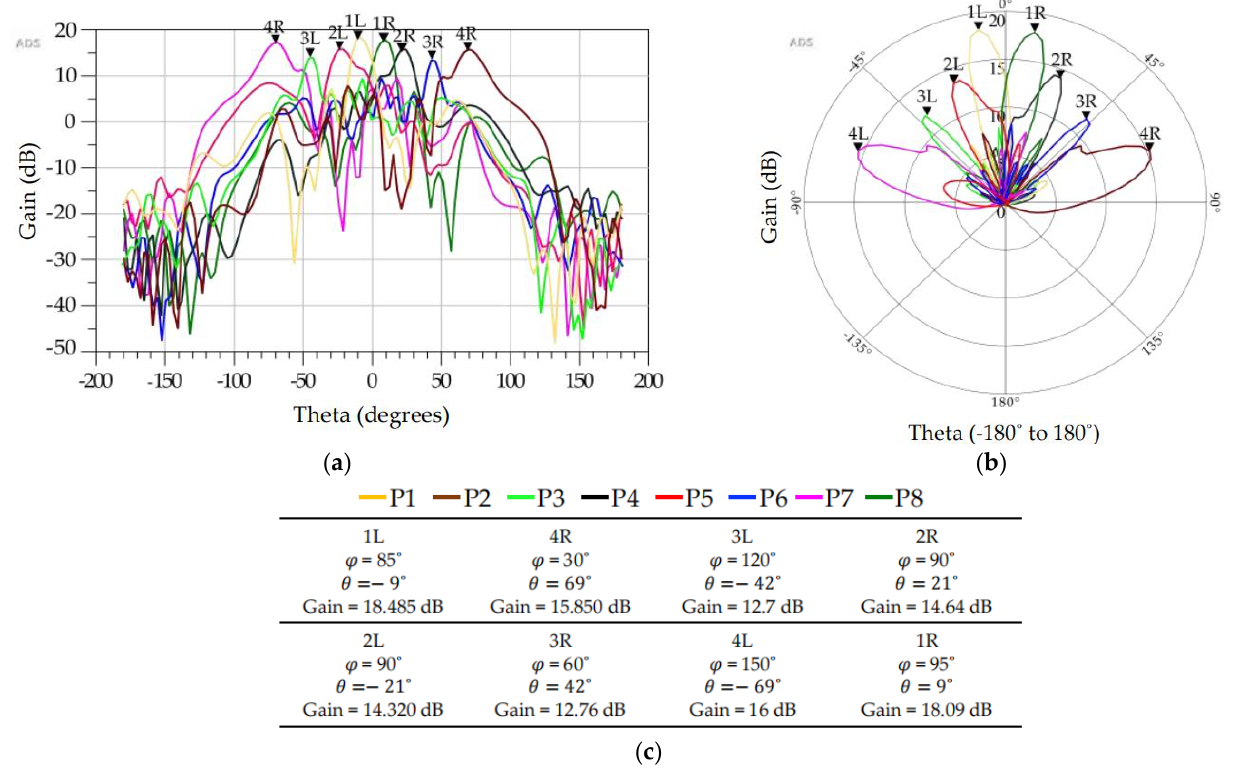
Figure 23. Three dimensional FEM simulated radiation patterns generated by ADS. ( a ) Radiation patterns in rectangular coordinates when the beam ports are excited individually, ( b ) radiation patterns in polar coordinates when beam ports are excited individually, ( c ) corresponding simulation parameters for the beam ports.